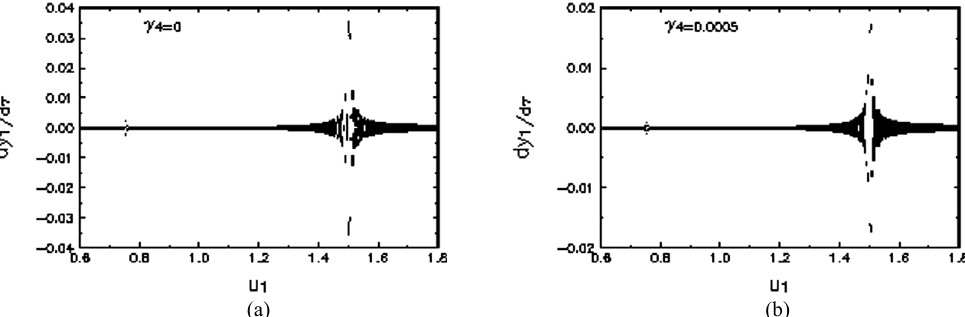
Fig. 5. Bifurcation diagrams of y for γ 4 = 0 (a) and γ 4 = 0.0005 (b) and for: a 1 = a 2 = 0.1; a 3 = 0.0001; γ 1 = 0.0001; γ 2 = γ 3 = 0; β 1 = 0.65; c = 1; u 2 = 1.5; q = 0.2.